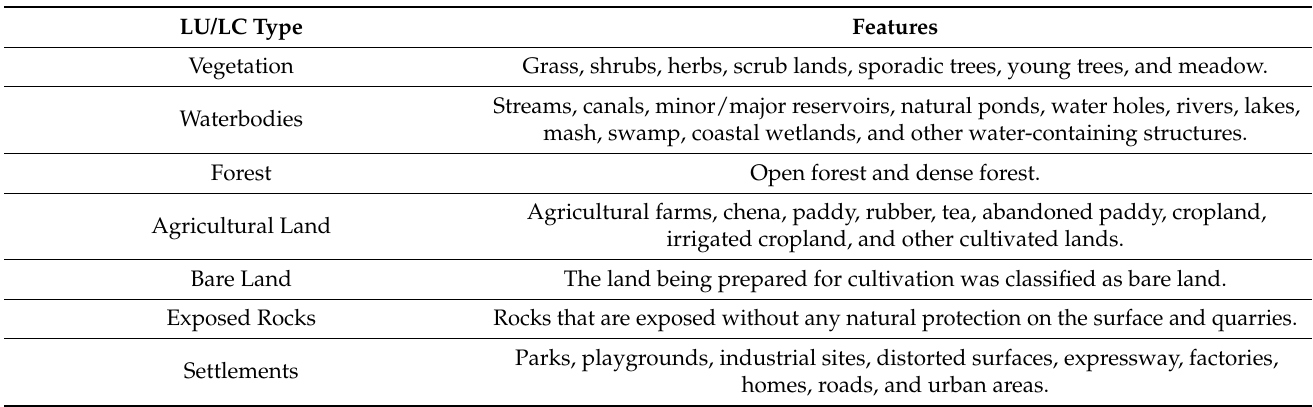
Table A10. Land use/land cover types and relevant features that are considered in the